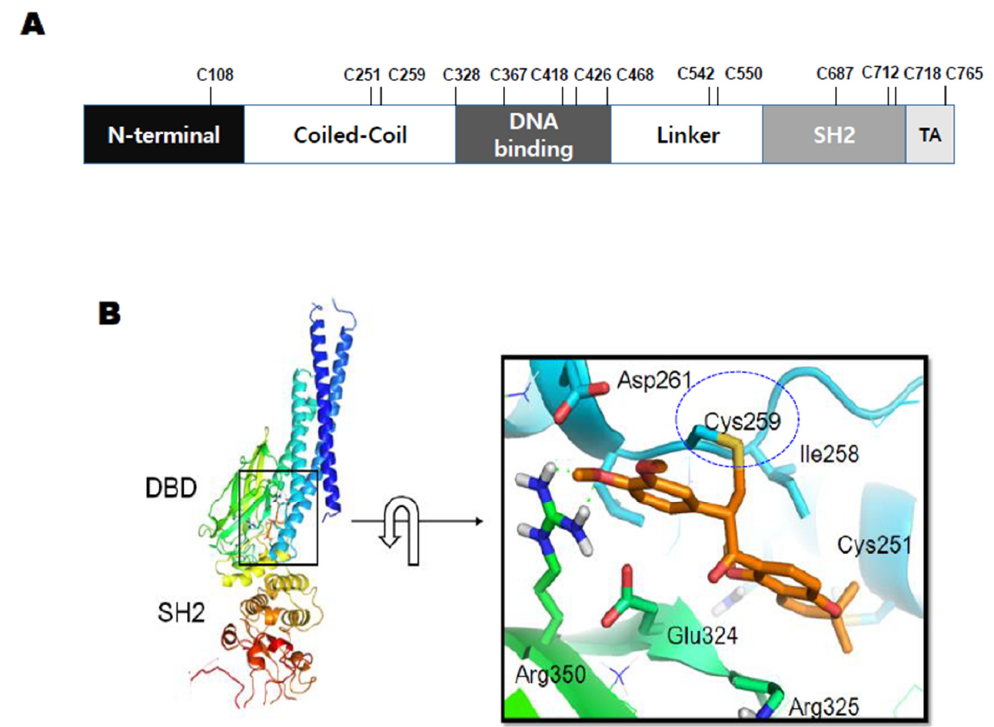
Figure 5. Putative interaction between the cysteine 259 residue of STAT3 and SH48 determined by computer modeling. ( A ) Cysteine residues present in human STAT3. SH2, Src Homology 2 domain; TA, transactivation domain. ( B ) The covalent binding pose of the α , β -unsaturated carbonyl group of SH48 to Cys259 of STAT3. DBD, DNA-binding domain; SH2, Src Homology 2 domain.